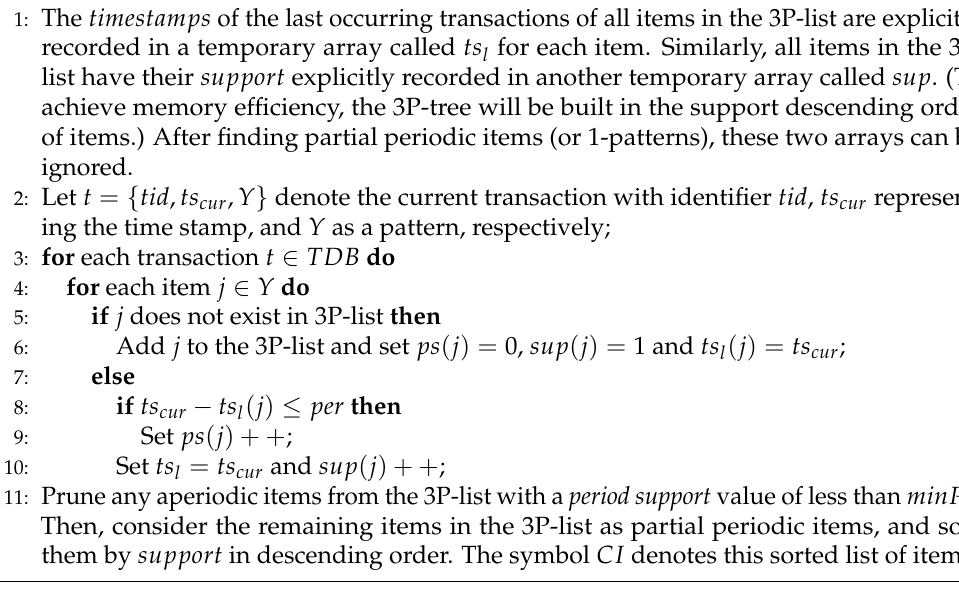
Algorithm 1 Construction of 3P-list: TDB , temporal database; I , set of items; minPS , minimum period support; per ,